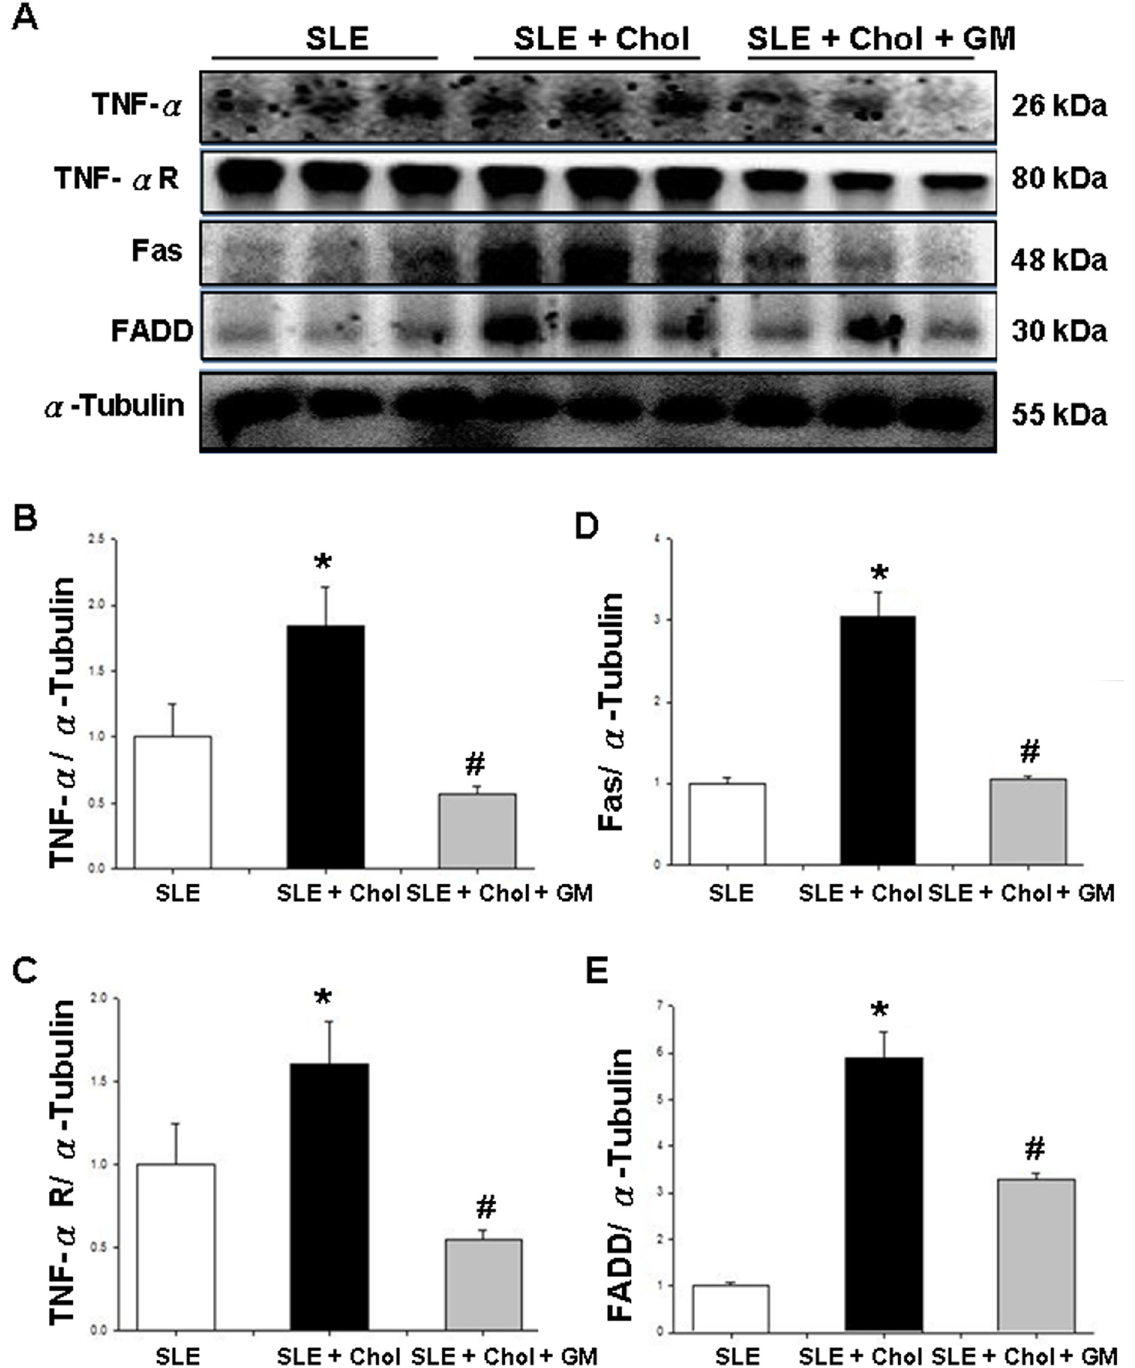
Fig 2. Variation of Fas-related components in the left ventricular tissues of NZB/W F1 mice fed with different dietary supplements. (A) Expressions of TNF- α , TNF- α receptor, Fas and FADD in left ventricles of hearts from NZB/W F1 mice that were fed with different supplementations, measured by Western blotting analysis. α -Tubulin served as an internal control. Bars represent quantities of (B) TNF- α , (C) TNF- α receptor, (D) Fas and (E) FADD relative to amount of α -Tubulin, respectively. * and # indicate significant differences relative to SLE and SLE + cholesterol groups, respectively. Similar results were obtained in triplicate experiments. SLE: systemic lupus erythematosus; Chol: cholesterol; GM: Gentiana macrophylla Pall.